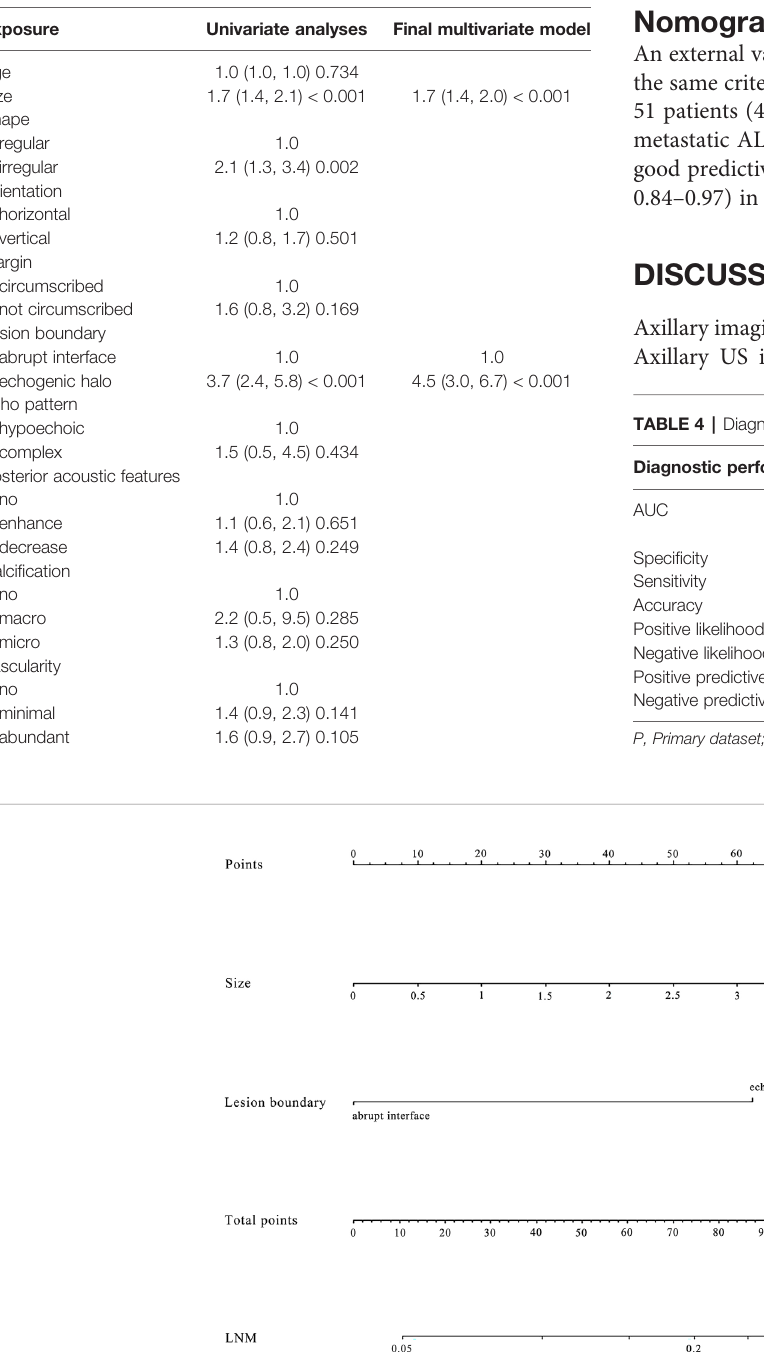
FIGURE 1 | The nomogram was developed in the primary dataset. it included two factors (size, lesion boundary). The nomogram plot provides a visual way to predict the risk of LN metastases for breast cancer patients.